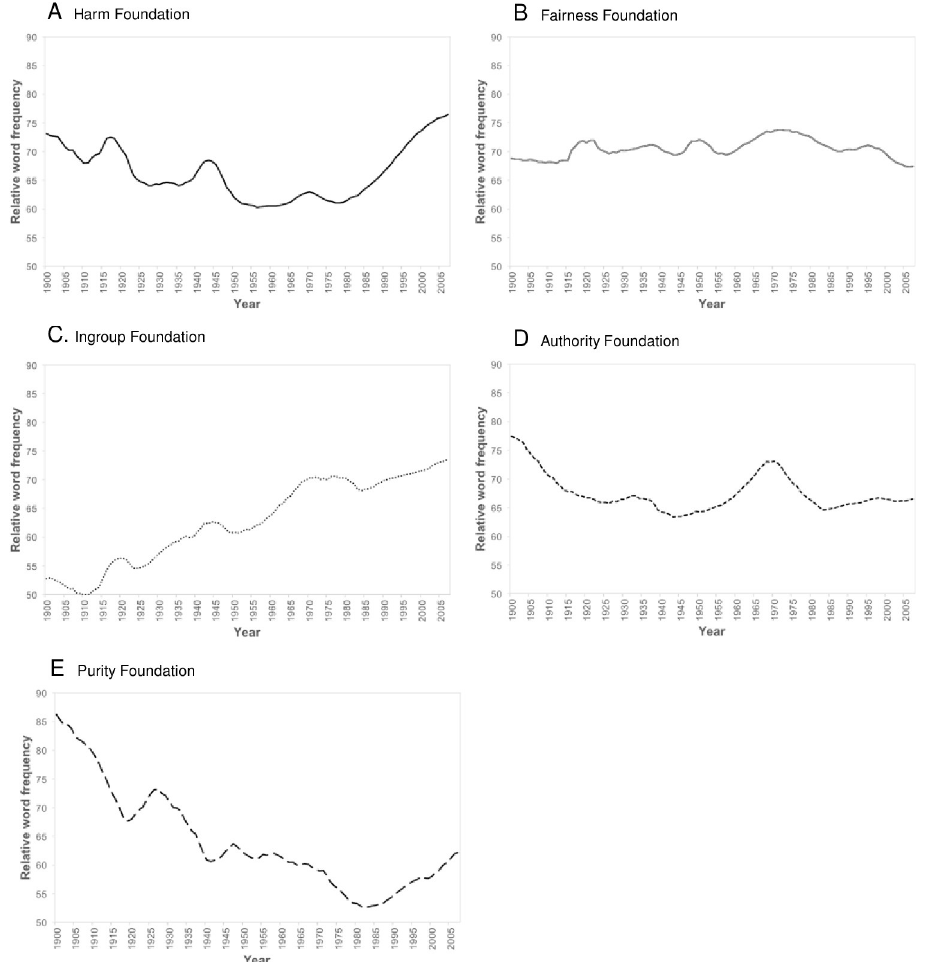
Fig 2. Time series of moral foundations indices from 1900 to 2007: (a) Harm, (b) Fairness, (c) Ingroup, (d) Authority, (e) Purity.